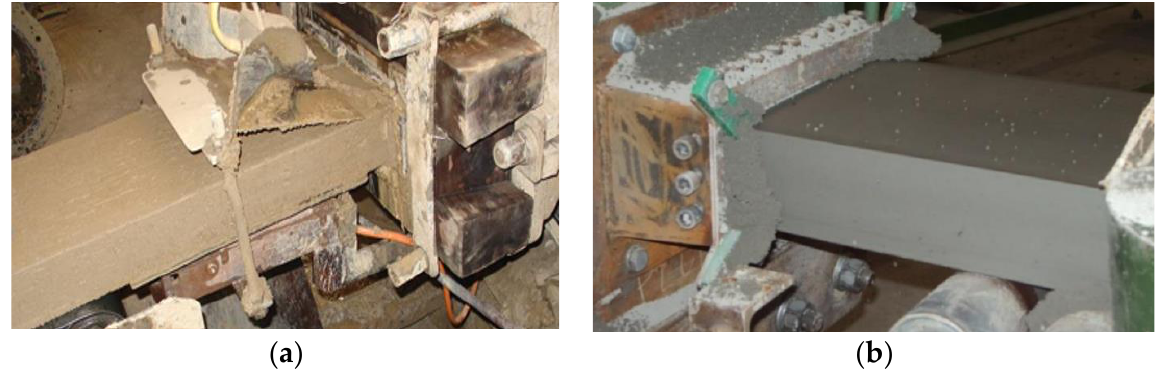
Figure 3. Clay extrusion process: ( a ) extruded bar of clay S2, ( b ) extruded bar of clay S3.